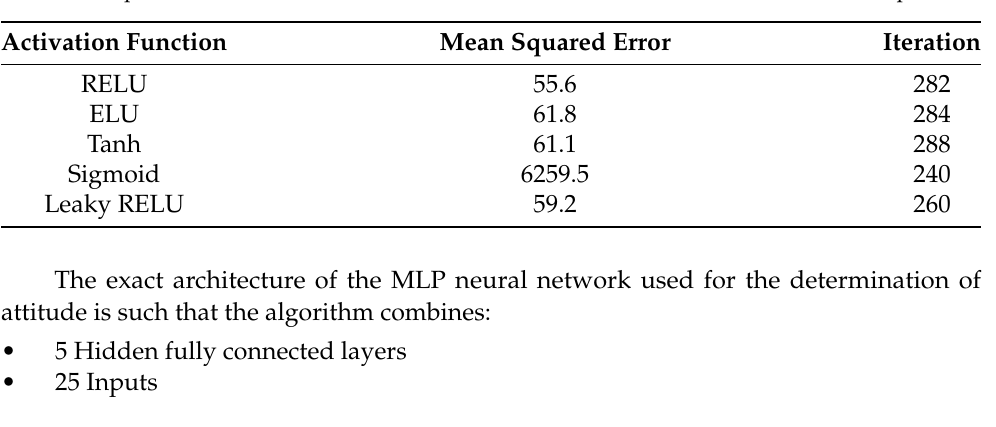
Table 1. Averaged results obtained for each activation function comparing their mean squared error between the predicted and desired azimuth as well as the number of iterations to reach the